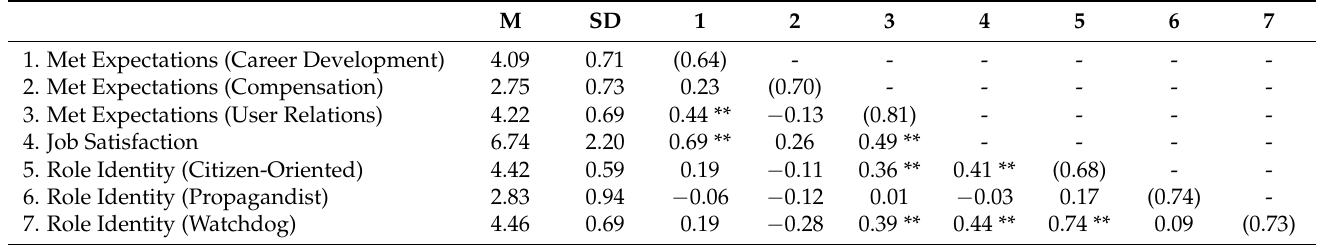
Table 1. Correlations and Descriptive Statistics for Key Study Variables (N =